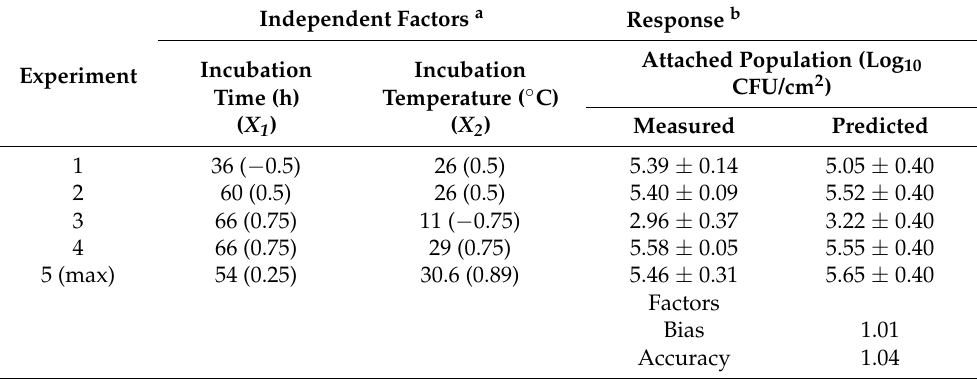
a Codes values are shown in parentheses. b Values are means ± standard